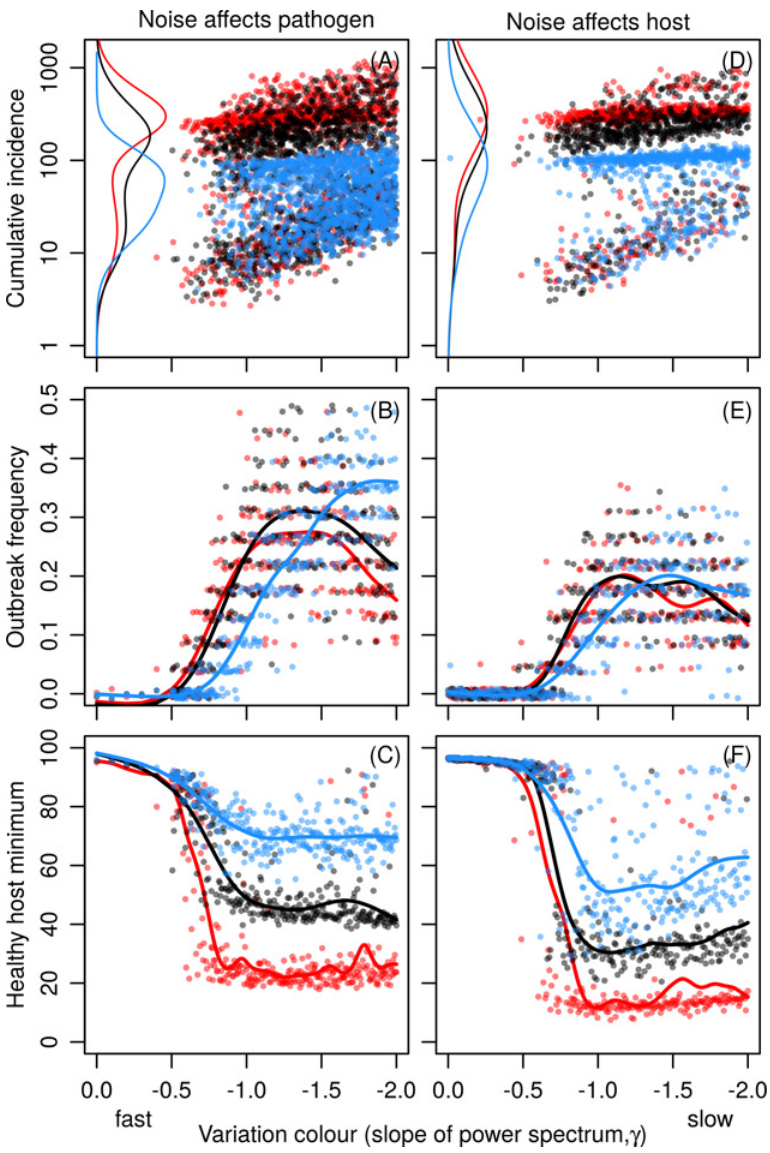
Fig 3. The effect of stochastic variation colour. The effect of the colour of stochastic variation (spectral exponent) on epidemiology. Left panels (A) – (C): variations affect pathogen growth rate r p . Right panels (D) – (F): variations affect 50% infective dose ID 50 . Top panels (A) and (D): Cumulative incidences. Each dot represents a single outbreak, the number of which varies between simulations, and the lines show a marginal kernel density estimate of peak areas. Panels (B), (C), (E) and (F): number of peaks and minimum value of healthy host density. Each dot represents a single simulation run. The lines show smoothing spline fits to the points. In the left panels variance A = 0.0625. In the right panels variance A = 0.01. Colours red, black, and blue show results on rapid, intermediate, and slow immunity loss rates, respectively. See Table 1 for model